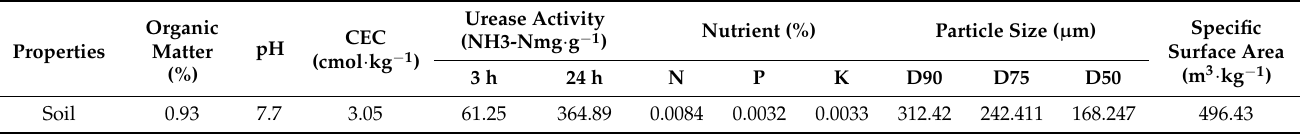
Table 1. Properties of the original loess soil from Gansu province of